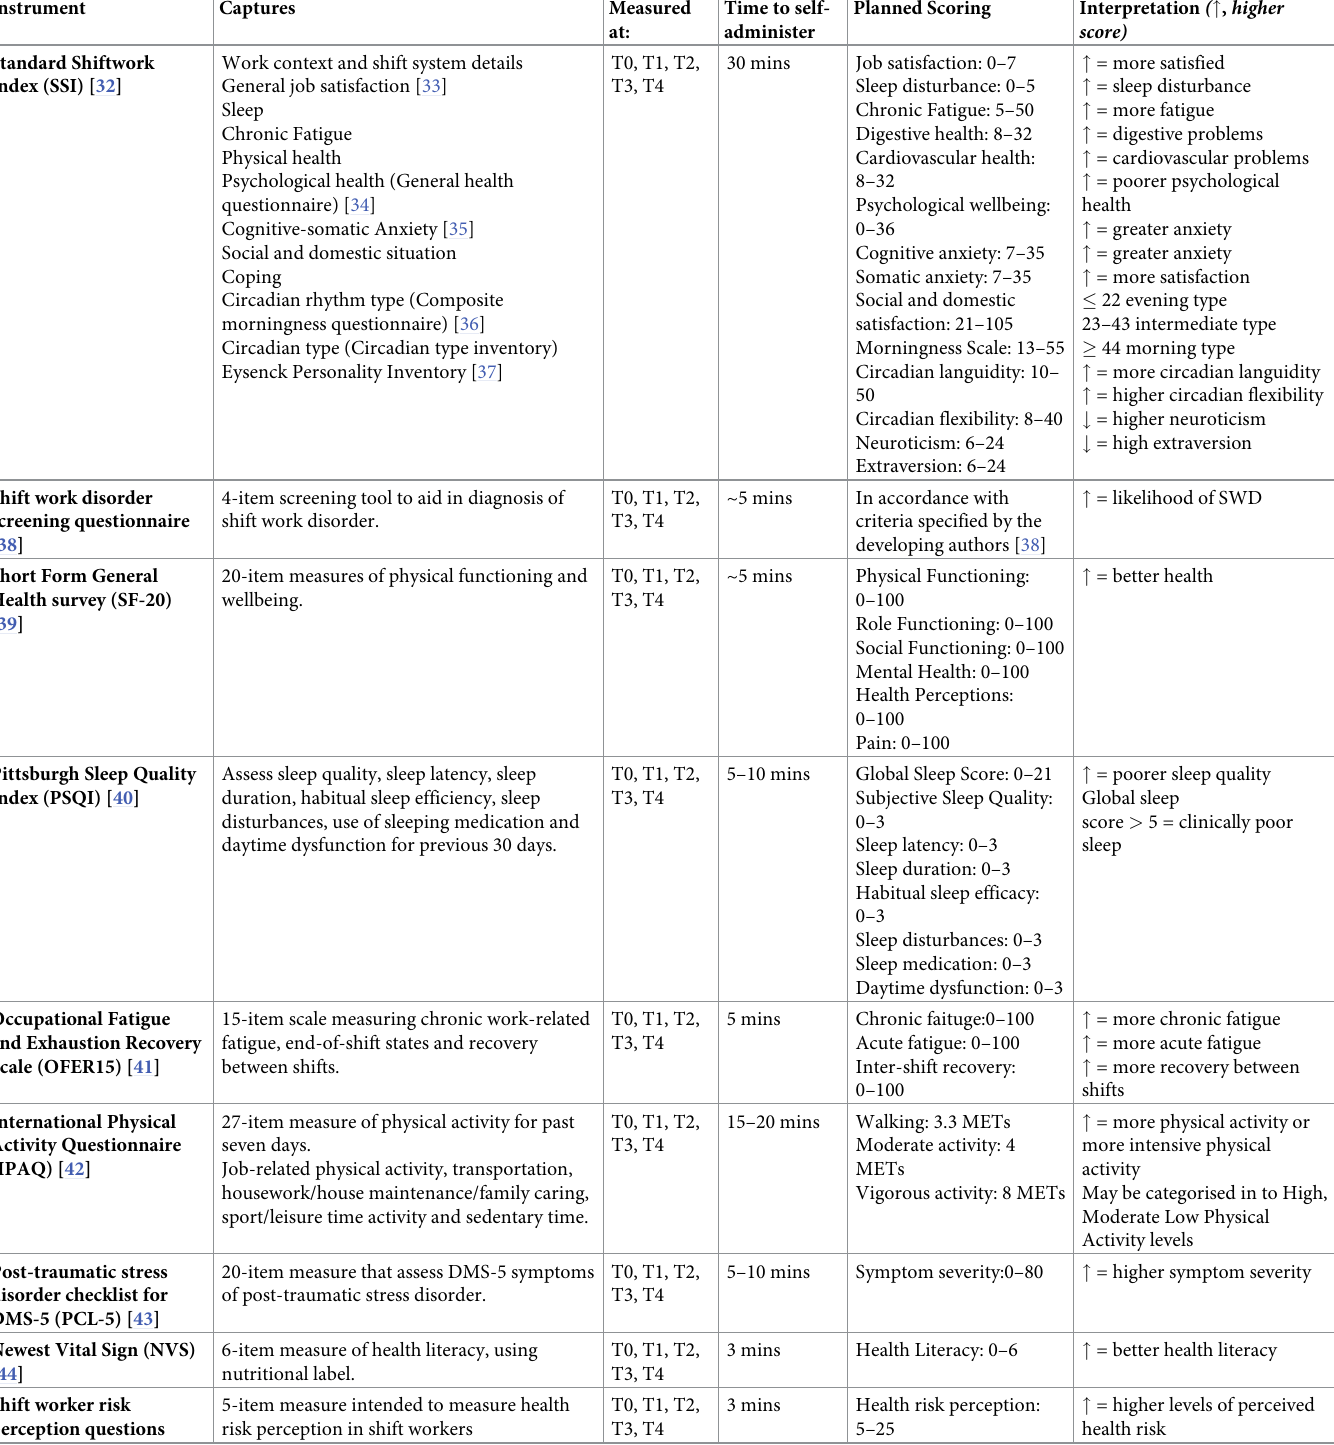
Table 2. Overview of characterises of self-administered measures.